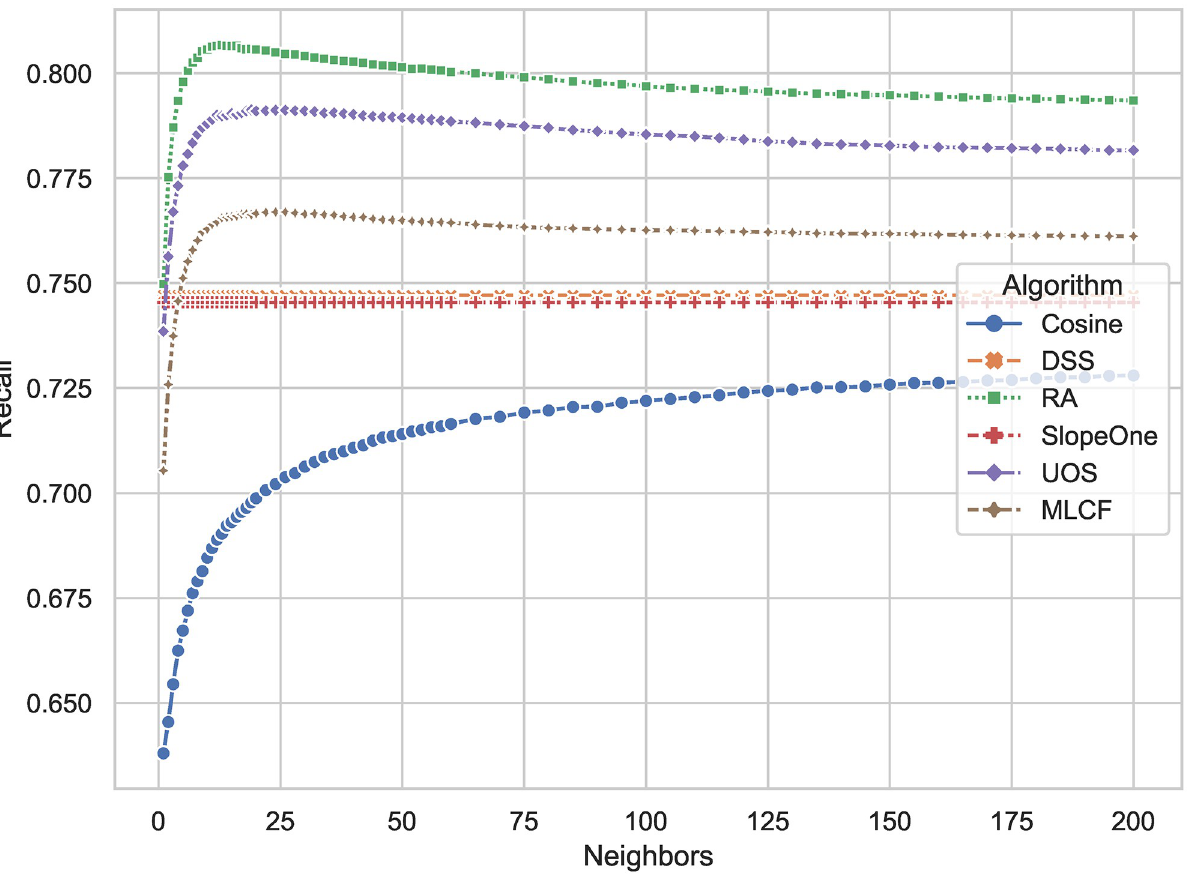
Fig 10. Recall results of different algorithms. The larger the result, the less false negatives the algorithm has in predicting the user’s preferences, and the less likely the algorithm will give a recommendation list that leaves out the items the user likes.